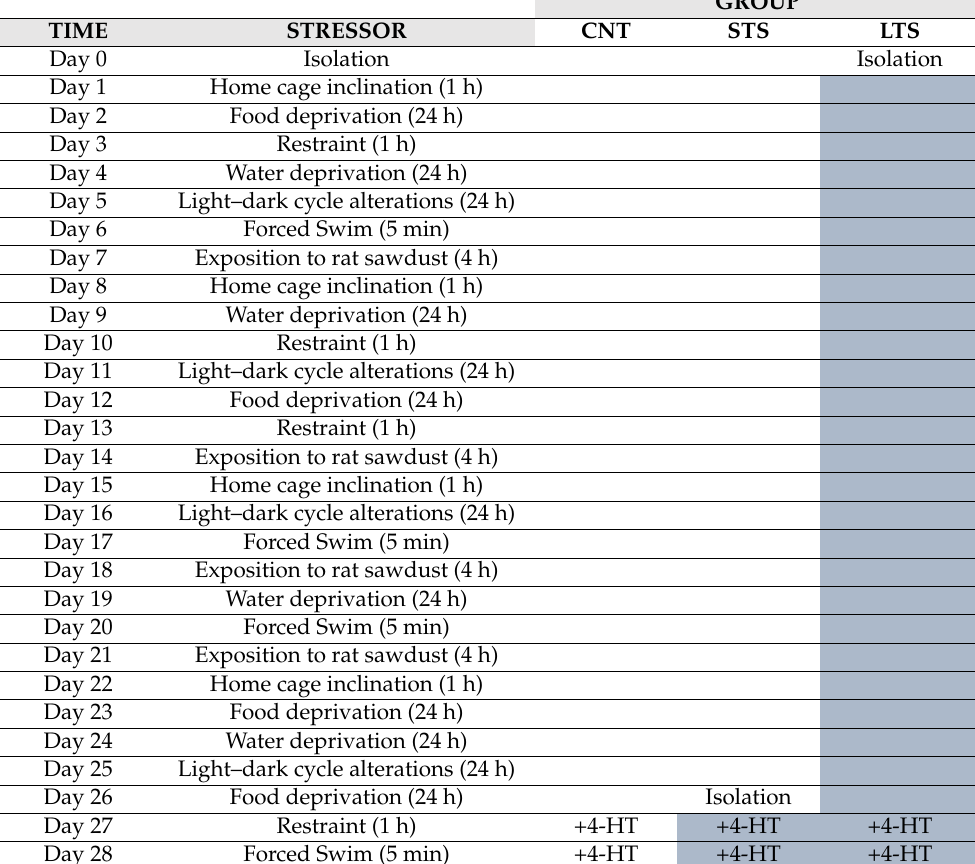
Table 1. Schematic organization of the chronic unpredictable mild stress protocol.